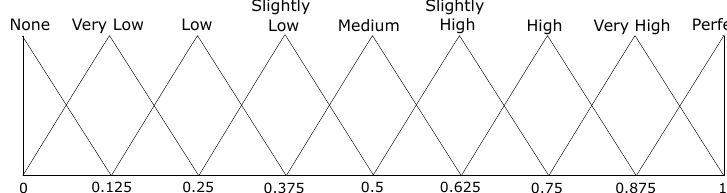
Figure 3. The ELICIT expression